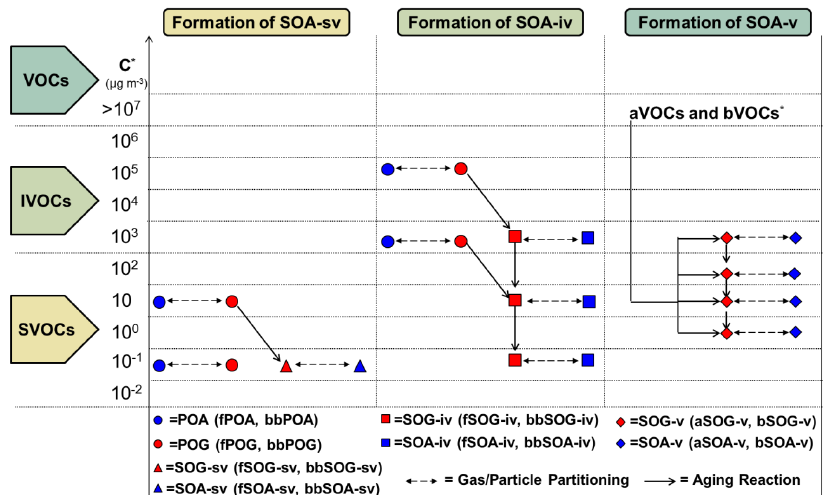
Figure 2. Schematic of the VBS resolution and the formation procedure of SOA from SVOC, IVOC, and VOC emissions. Red indicates that the compound is in the vapor phase and blue in the particulate phase. The circles correspond to primary organic material that can be emitted either in the gas or in the aerosol phase. The triangles indicate the formation of SOA from SVOCs by fuel combustion and biomass burning sources, while the squares show SOA from IVOCs by fuel combustion and biomass burning sources, and the diamonds the formation of SOA from anthropogenic and biogenic VOC sources. The partitioning processes, the aging reactions, and the names of the species used to track all compounds are also shown. ∗ For this application it is assumed that SOA formed by biogenic VOCs does not participate in aging reactions (Lane et al., 2008; Tsimpidi et al., 2010).